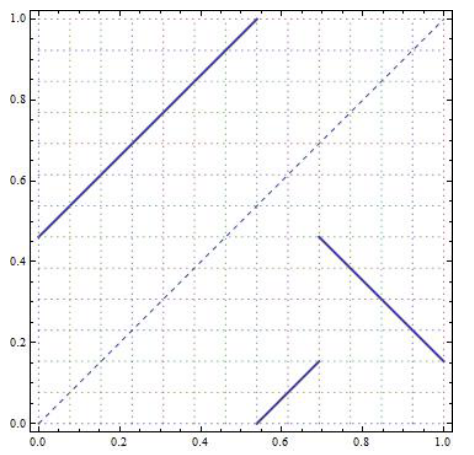
Figure 14. The graph of a ( 3,1 ) -IET with permutation ( 3,1, − 2 ) and λ = ( 7,2,4 ) .